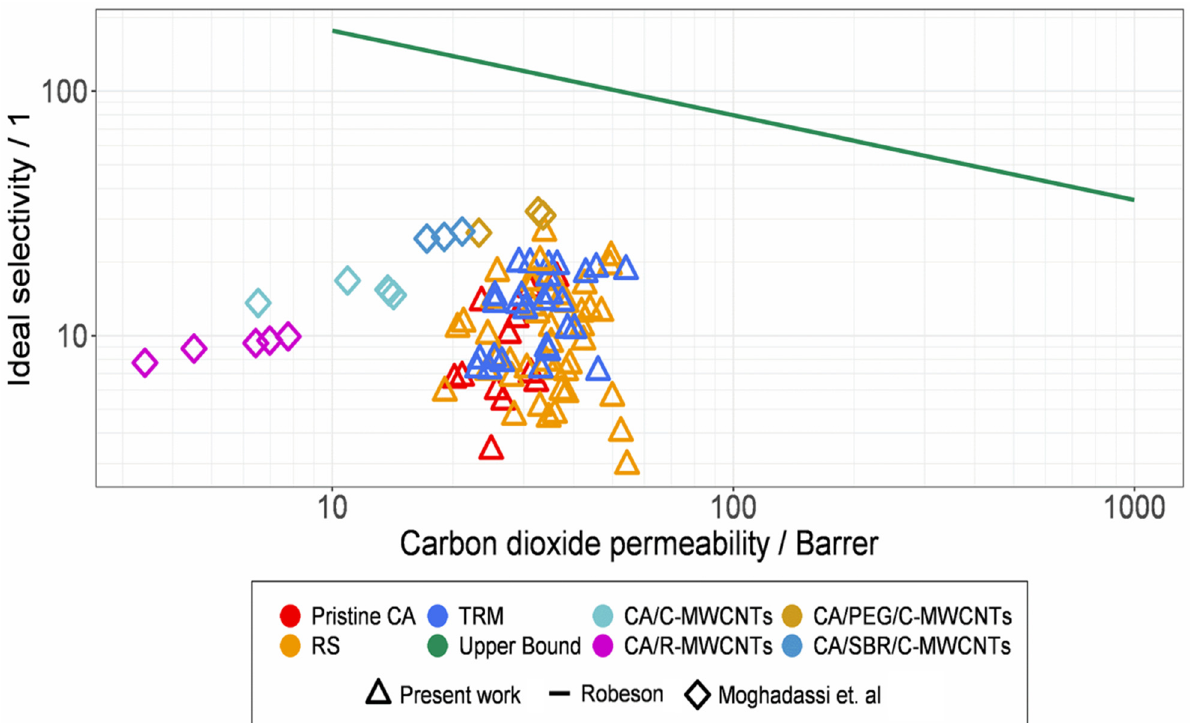
Figure 16. CO 2 permeability and corresponding CO 2 /N 2 selectivity in comparison to the Robeson upper bound